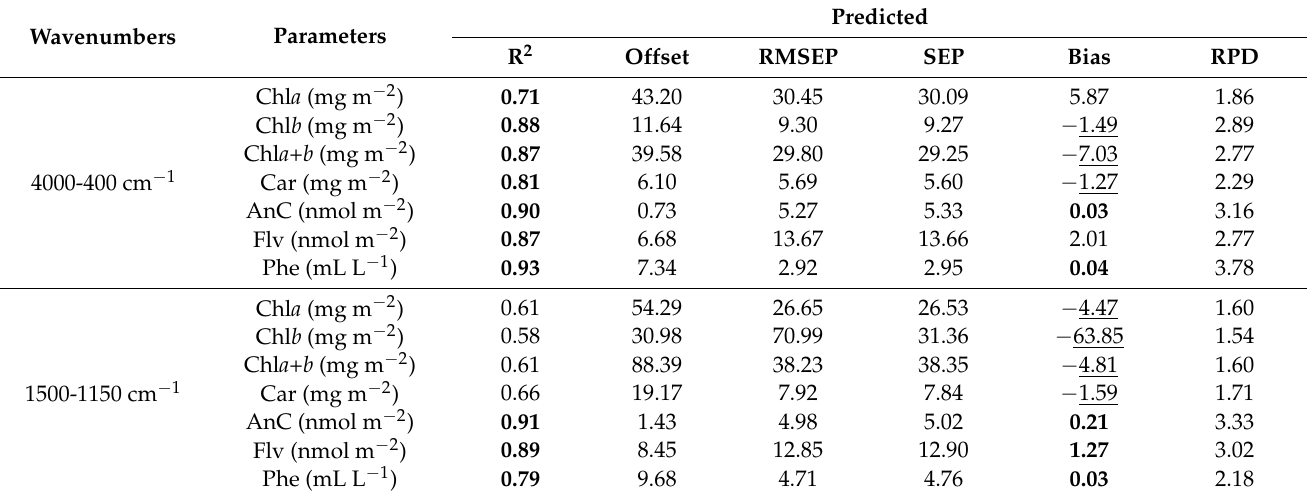
Table 3. PLSR model in the predicted phase. Model goodness-of-fit (R 2 ), offset, root mean square error (RMSEP), standard error of prediction (SEP), bias and ratio of performance to deviation (RPD) param- eters from ATR-FTIR spectroscopy data of lettuce leaves. The bold represents statistically significant regression models (R 2 ). The underline indicates a bad Bias calculated. Parameter